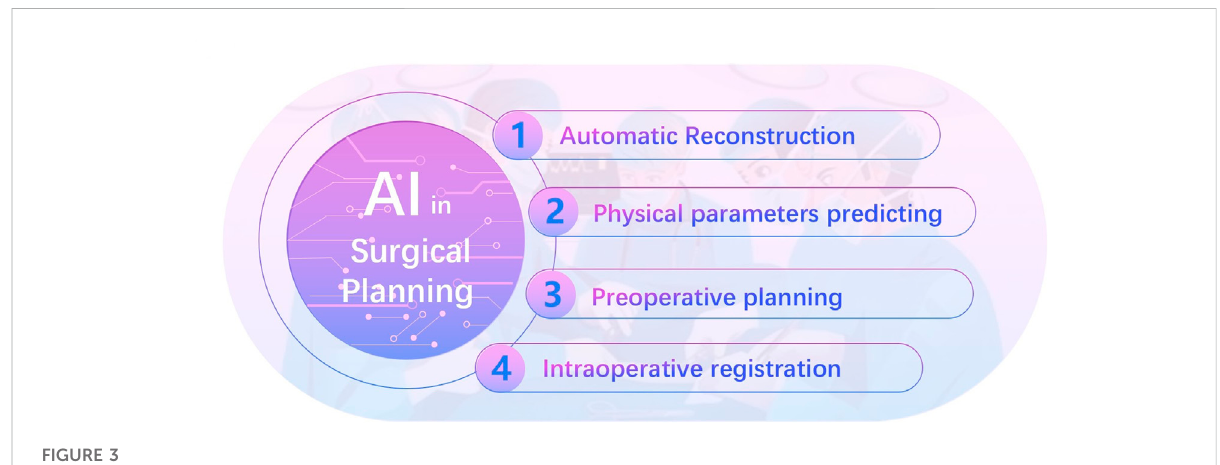
FIGURE 3 AI in surgical